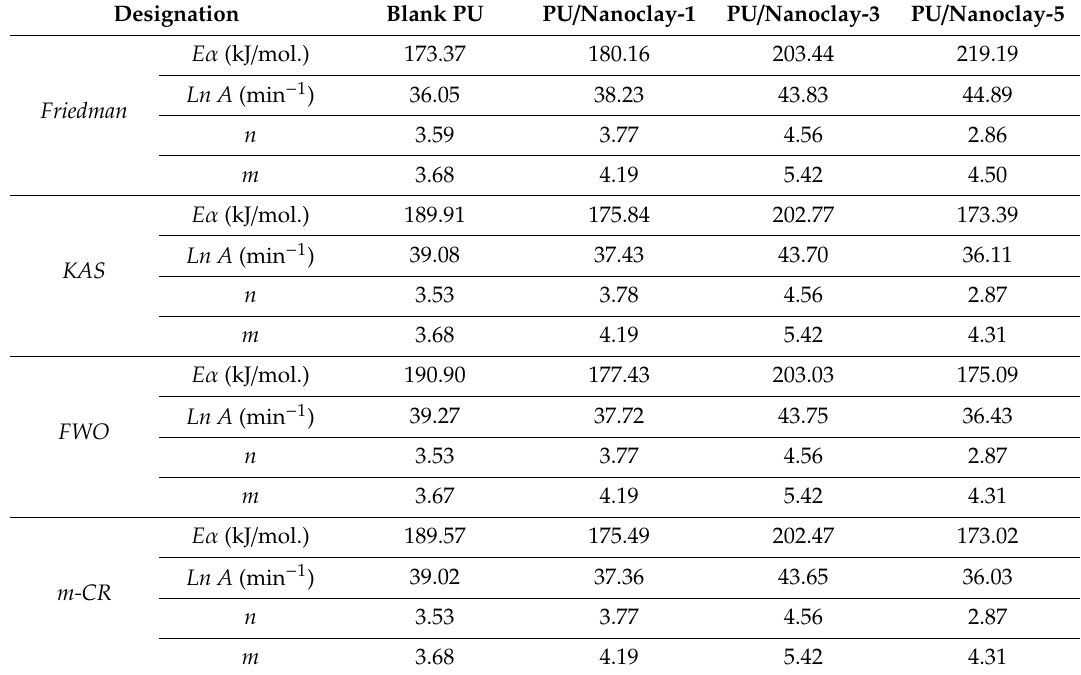
Table 3. Decomposition parameters based on the Sestak-Berggren decomposition reaction of